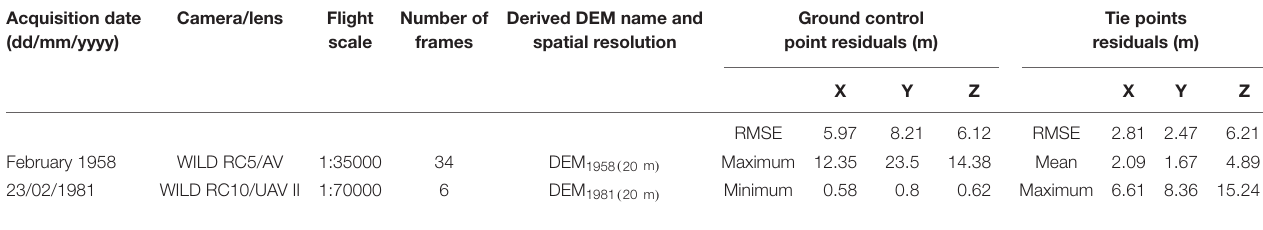
TABLE 1 | Characteristics of the utilized aerial photos and derived